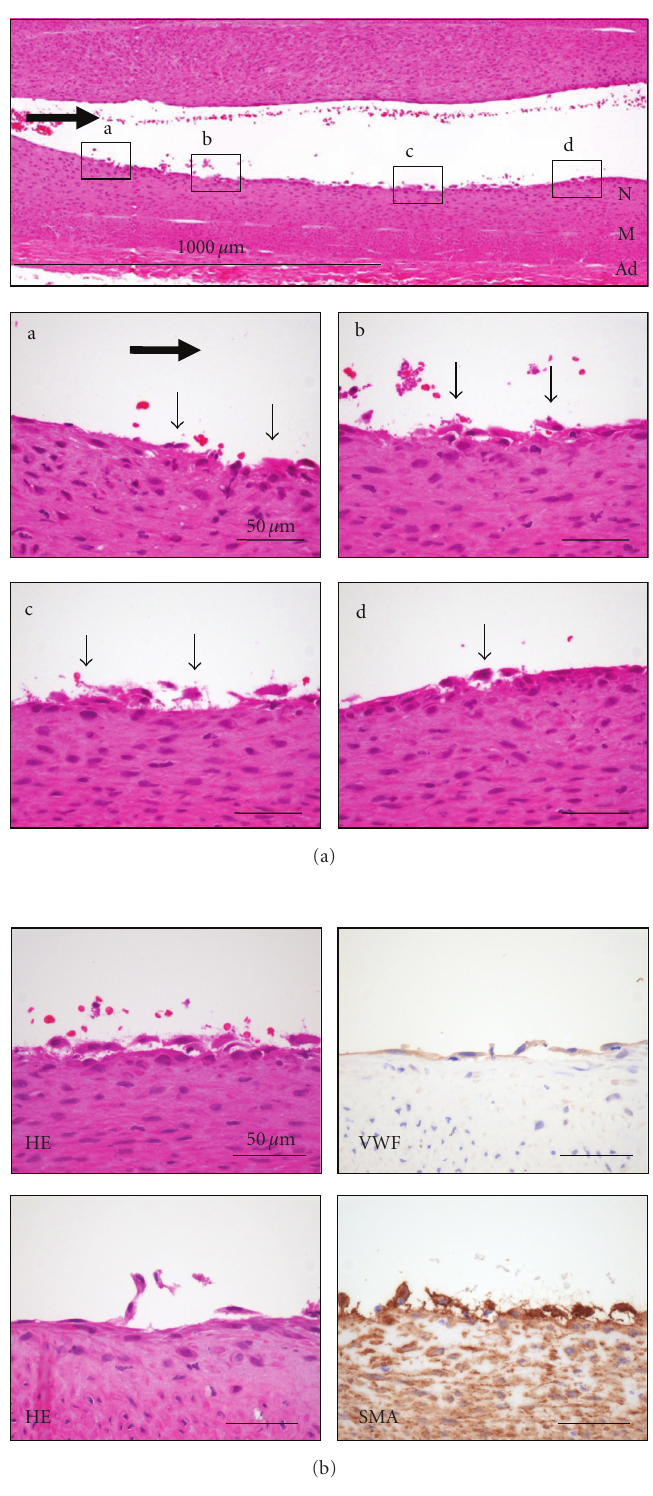
Figure 6: Representative longitudinal microphotographs of rabbit femoral artery with smooth muscle cell-rich neointima 15 minutes after vascular narrowing. (a) Broad superficial neointimal damage at poststenotic region. Neointimal cell detachment (small arrows) at high magnification. N, neointima; M, media; Ad, adventitia. Large arrow indicates blood flow. (b) Immunohistochemistry to detect von Willebrand factor (VWF, endothelial marker) and smooth muscle actin (SMA, smooth muscle marker) confirms detachment of endothelial and smooth muscle cells at poststenotic region. HE (hematoxylin eosin stain) (from Sumi et al.